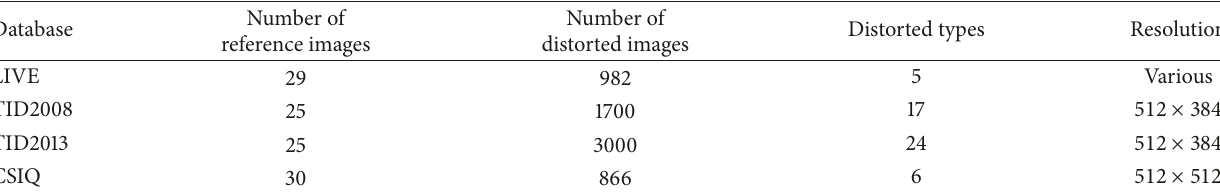
Figure 5: Structure diagram of dissimilarity quantification and quality mapping. Table 1: Fundamental information about the four largest databases used in our